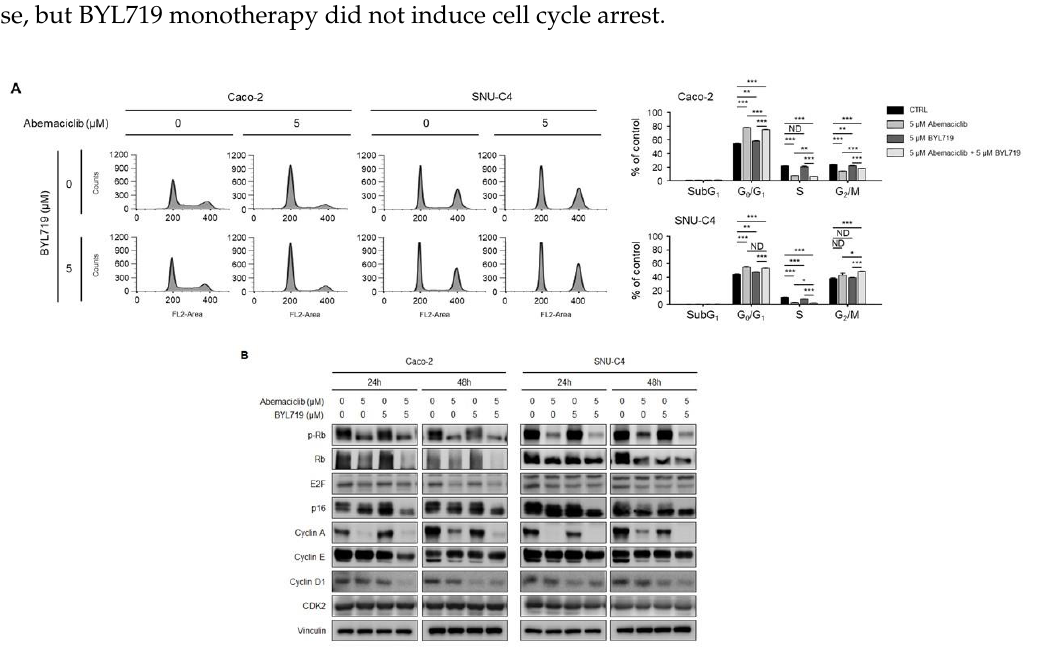
Figure 3. Abemaciclib and BYL719 combination inhibits the cell cycle and its regulatory proteins in Caco-2 and SNU-C4 cell lines. ( A ) Caco-2 and SNU-C4 cells were treated with 0 and 5 μM abemaciclib and/or 0 and 5 μM BYL719 for 48 h. Cell cycle distribution was plates and treated with the indicated concentrations of abemaciclib and BYL719 ( n =